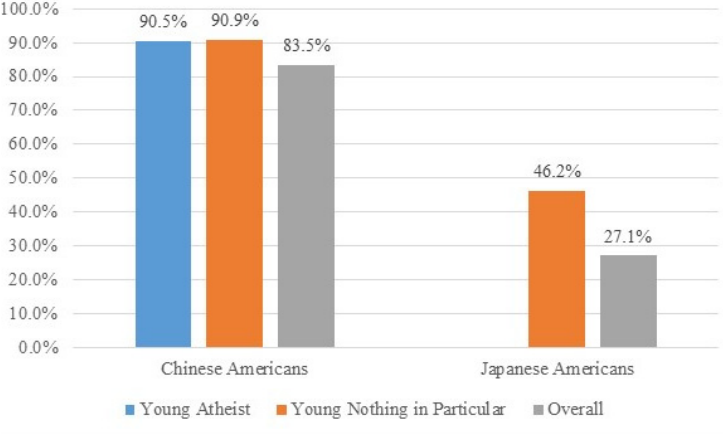
Figure 10. Celebrates Lunar New Year.